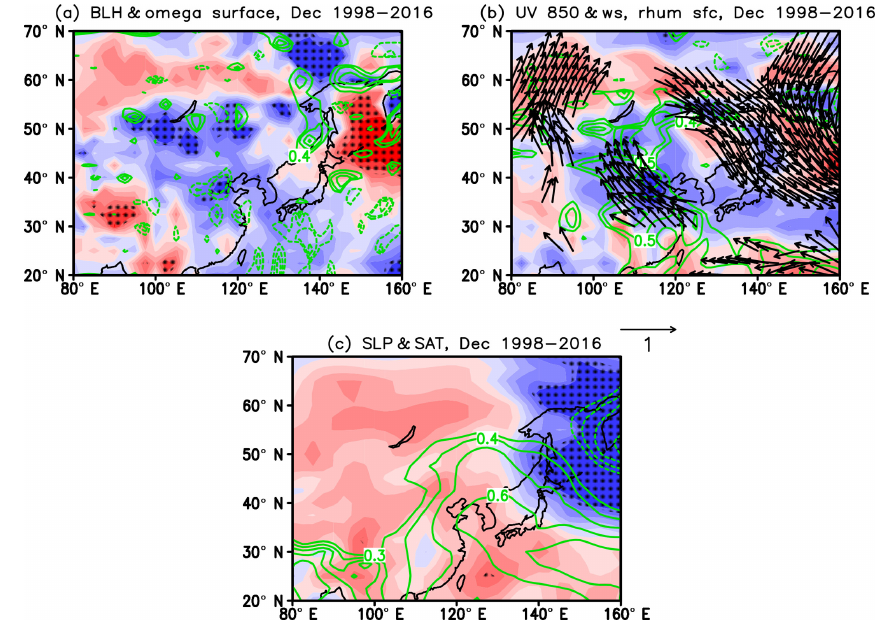
Figure 5. The CC between the SC ES and (a) BLH (shading) and surface omega (contour), (b) wind at 850hPa (arrow), surface wind speed (shading), and surface relative humidity (contour), and (c) SLP (contour) and SAT (shading) in December from 1998 to 2016. The black dots indicate the CC exceeded the 95% confidence level ( t test). The linear trend is removed.